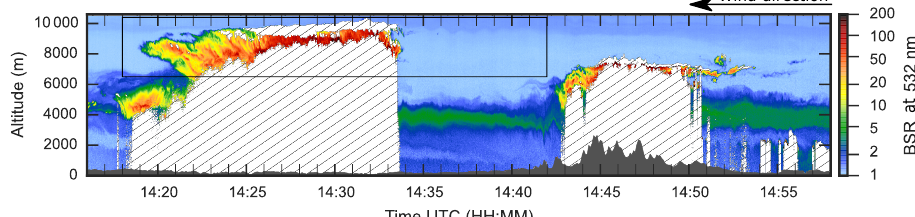
Figure 3. Backscatter ratio (BSR) at 532nm measured along the flight path (white line in Fig. 2). Hatched areas indicate data that were excluded due to detector saturation or low signal-to-noise ratio and the terrain profile is shown in dark gray. The black rectangle marks the cirrus region that is studied further (see Figs. 4 and 5). The arrow shows the main wind direction at cirrus